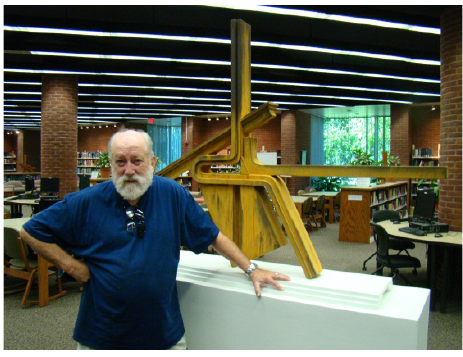
Retired faculty member Jim Agard poses with his sculpture, Consonance, one of the newest additions to